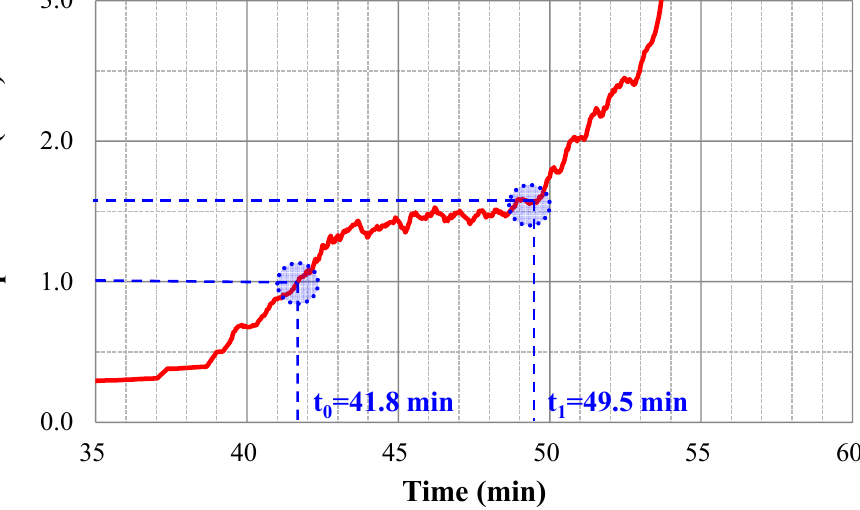
Figure 9. Displacements from 41.8 to 49.5 min (case 1).